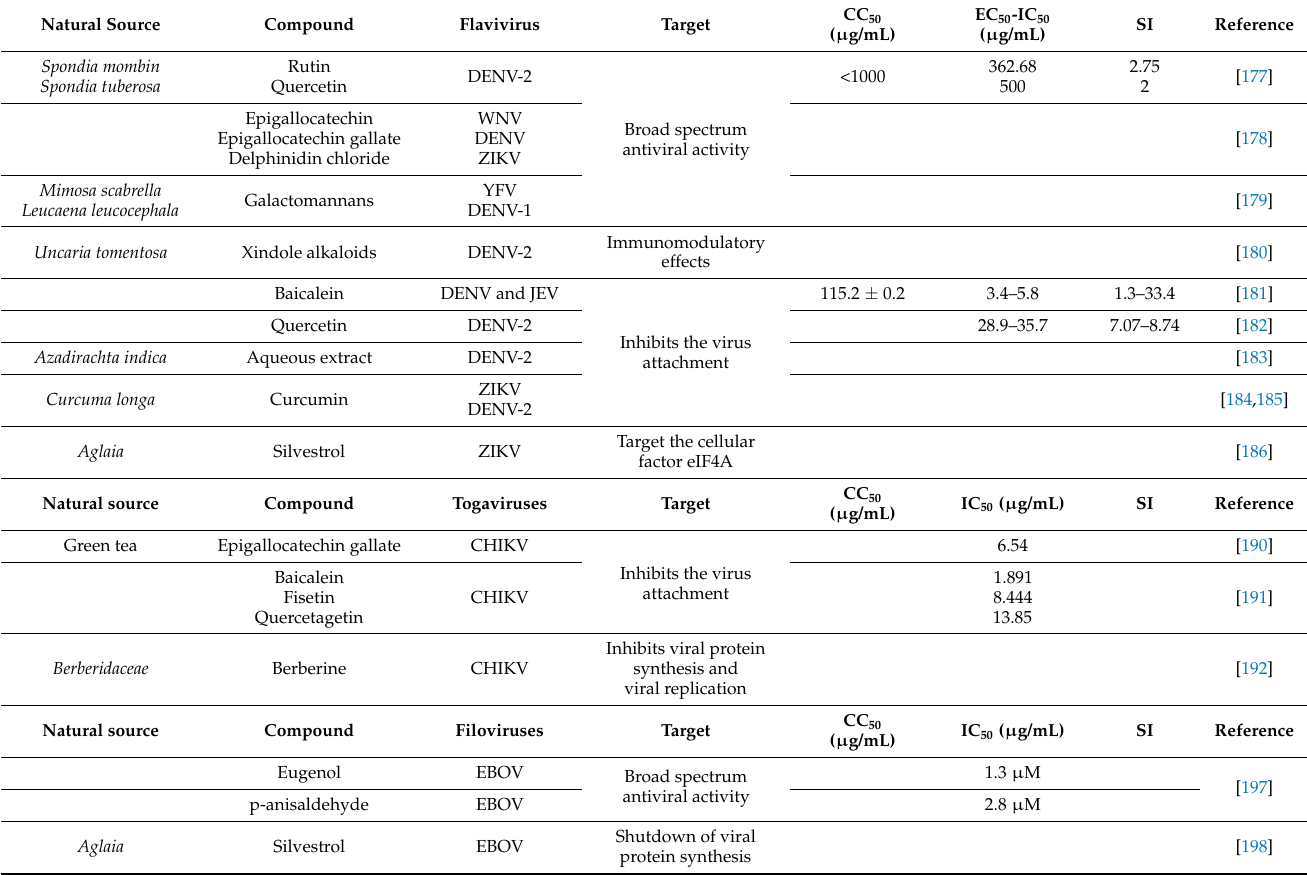
Table 11. Natural products against Flaviviruses, Togaviruses, and